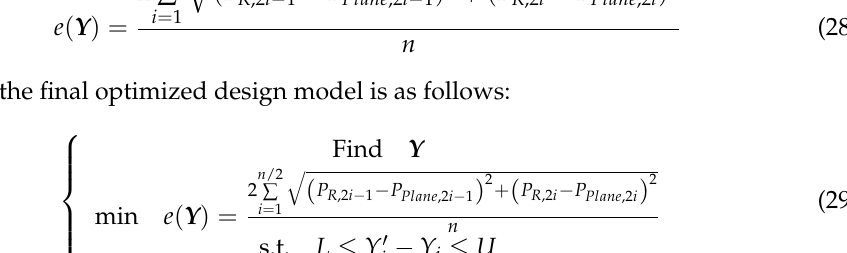
Table 3. Value of optimization model parameters.